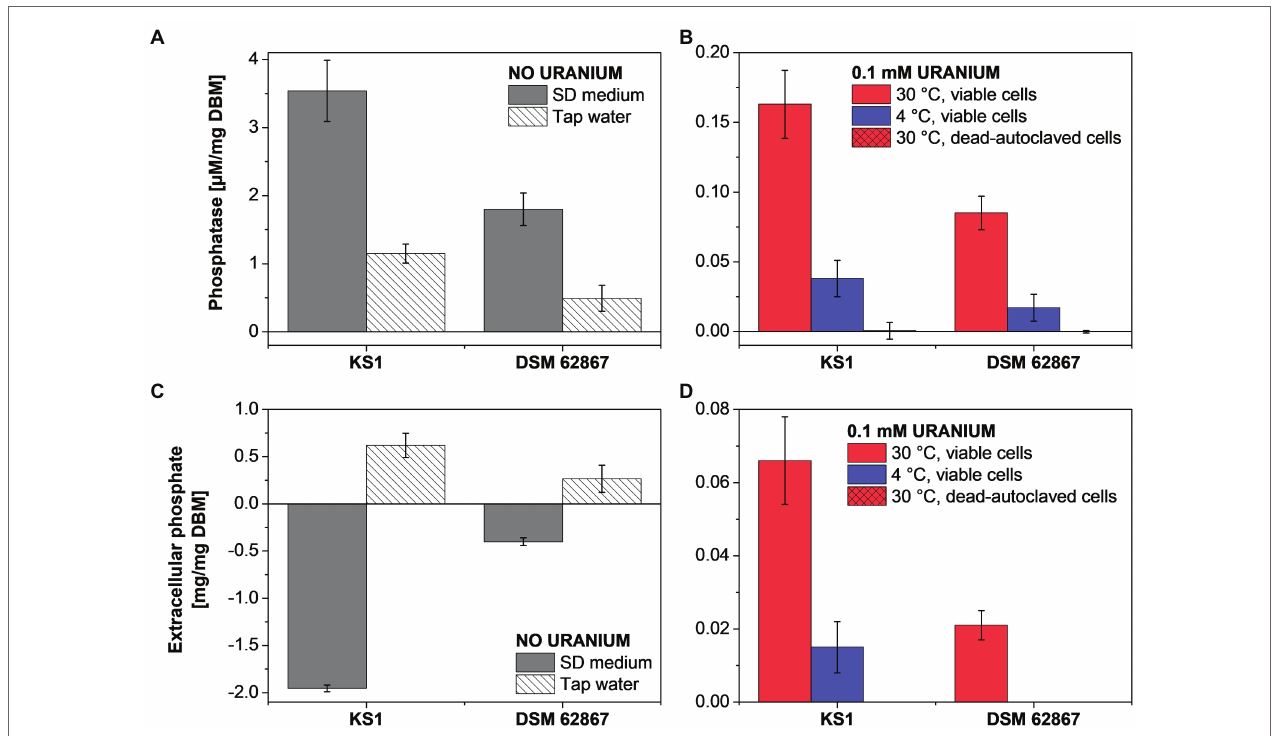
FIGURE 3 | Phosphatase activity (A,B) and extracellular phosphate (C,D) determination of P. simplicissimum KS1 and DSM 62867 after 48 h incubation without U in SD medium or tap water (A,C) and with 0.1 mM U in tap water (B,D)